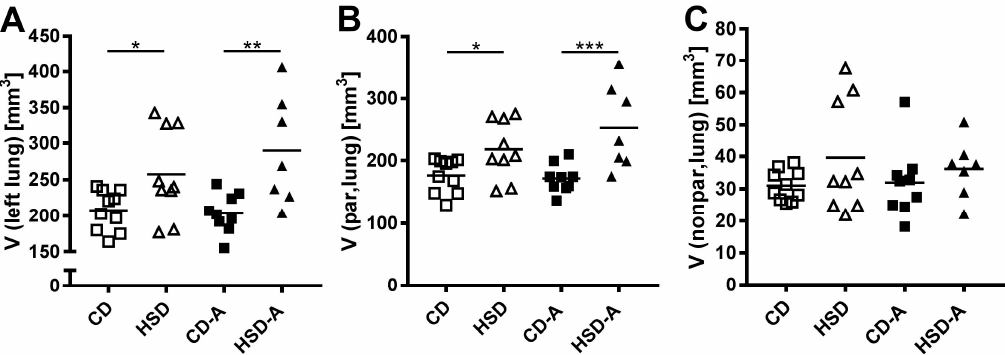
Figure 2. Effects of high sucrose intake and voluntary activity on lung and parenchyma volumes. Mice were fed a control diet (CD) or a high sucrose diet (HSD) and were left untreated or had access to running wheels (CD-A, HSD-A) for 30 weeks. A) Volume of the left lung; B) Volume of left lung parenchyma, C) Volume of left lung non-parenchyma. Values are individual data points, with means indicated by horizontal lines. Data were compared by 2-Way ANOVA followed by Tukey test; p -values < 0.05 are indicated: * p < 0.05, ** p < 0.01, *** p < 0.001.